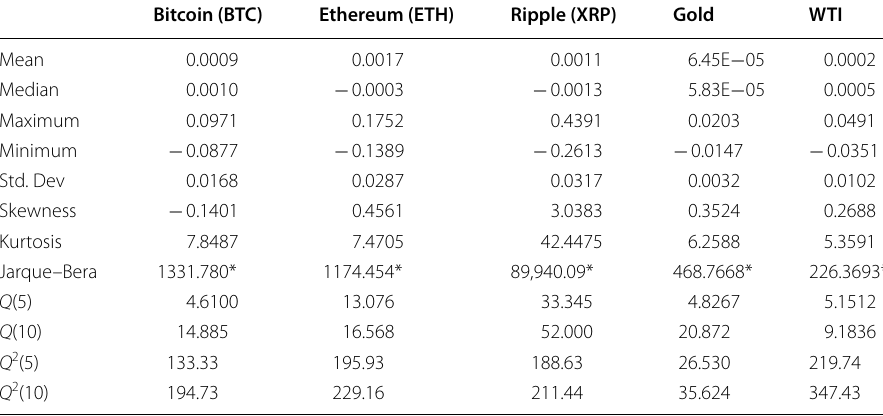
Table 1 Summary statistics of returns